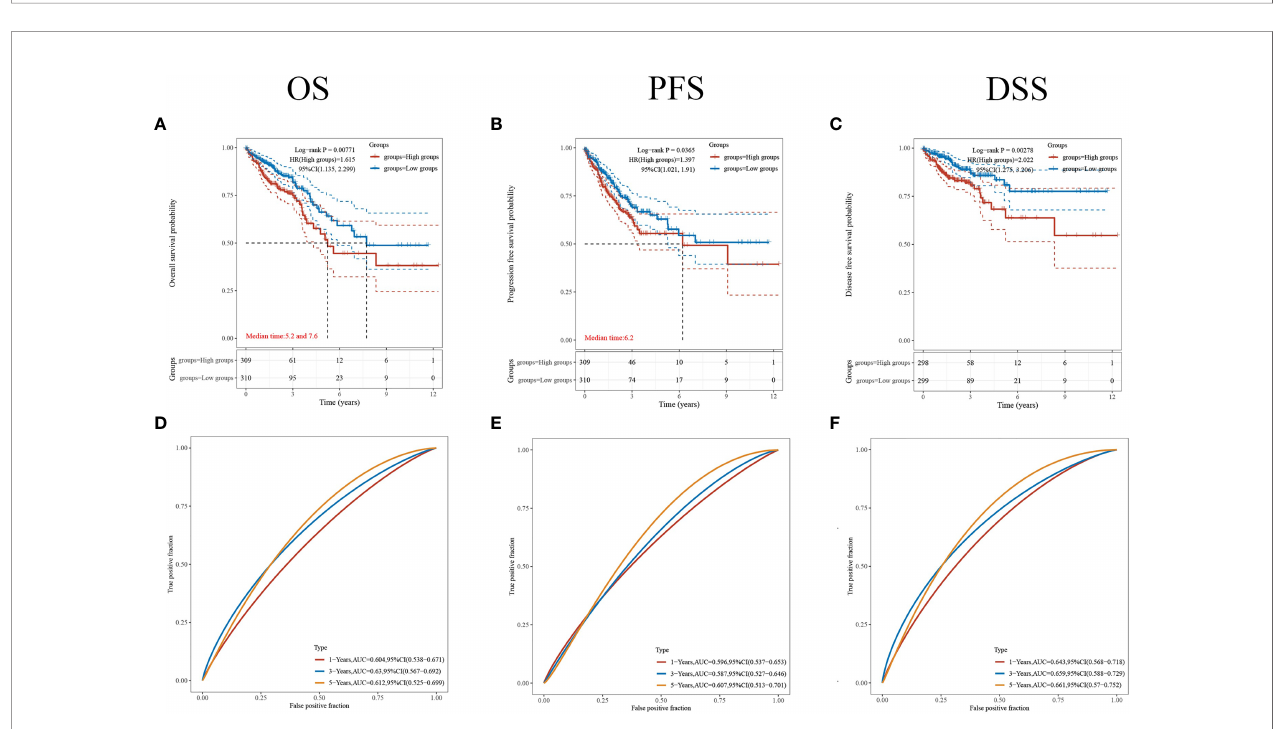
FIGURE 5 | Comparison of different survival types. (A – C) The OS, PFS and DSS of patients with CRC who expressed high levels of CDKN2A. (D – F) ROC curves of OS, PFS and DSS. p < 0.05 was considered statistically signi fi